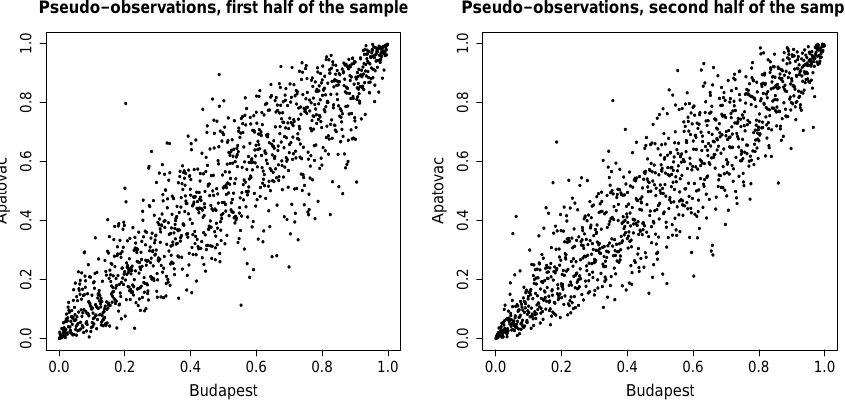
Figure 5. The pseudo-observations of Budapest and Apatovac for the first and the second half of the 10-day averages of the standardised